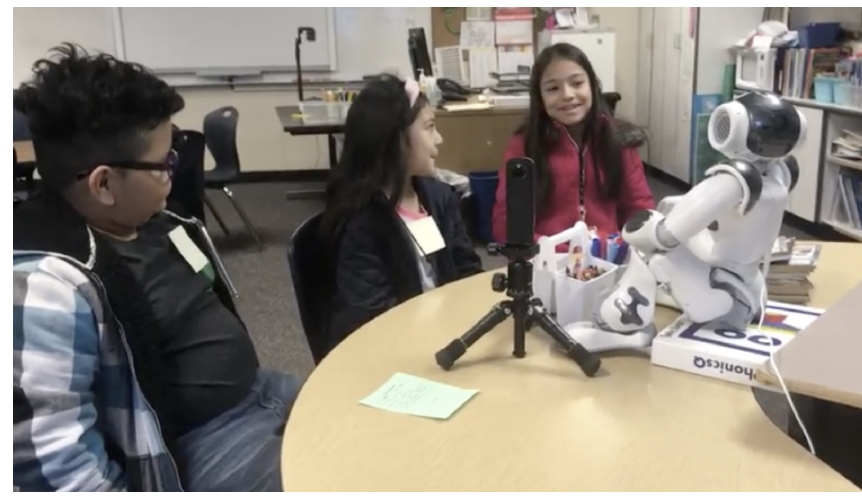
Figure 3. In this image, the three students are engaged in conversation with one